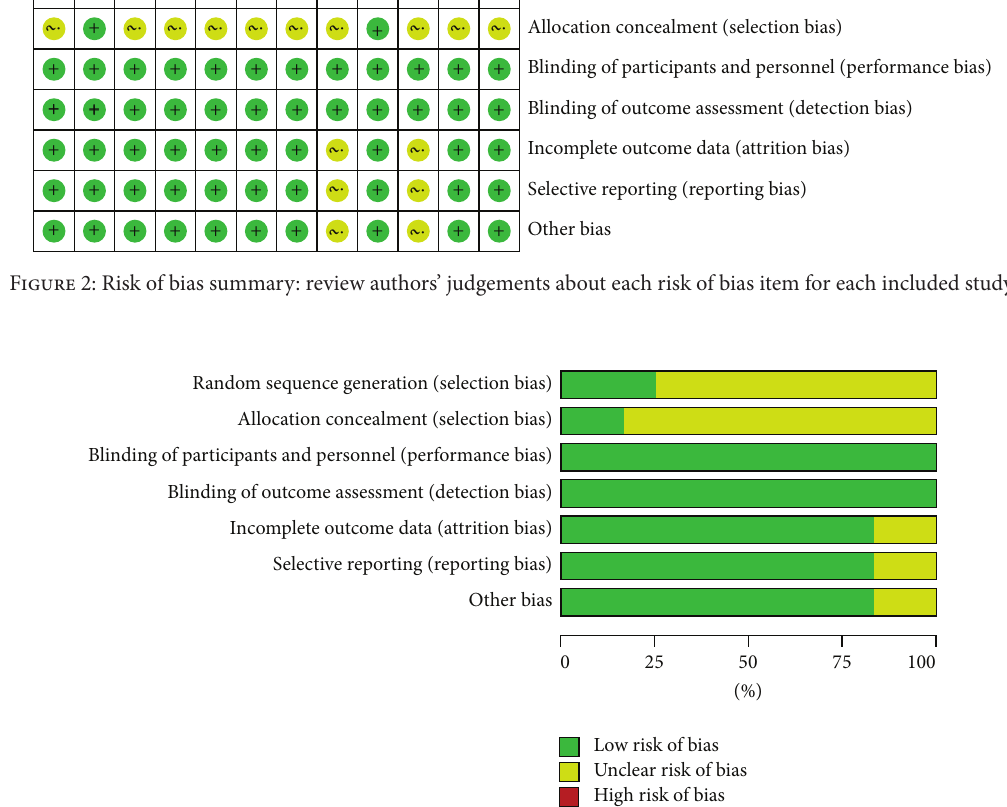
95% CI = 0.55–1.04), with no significant heterogeneity across studies ( 𝑃 = 0.28 , 𝐼 2 = 18